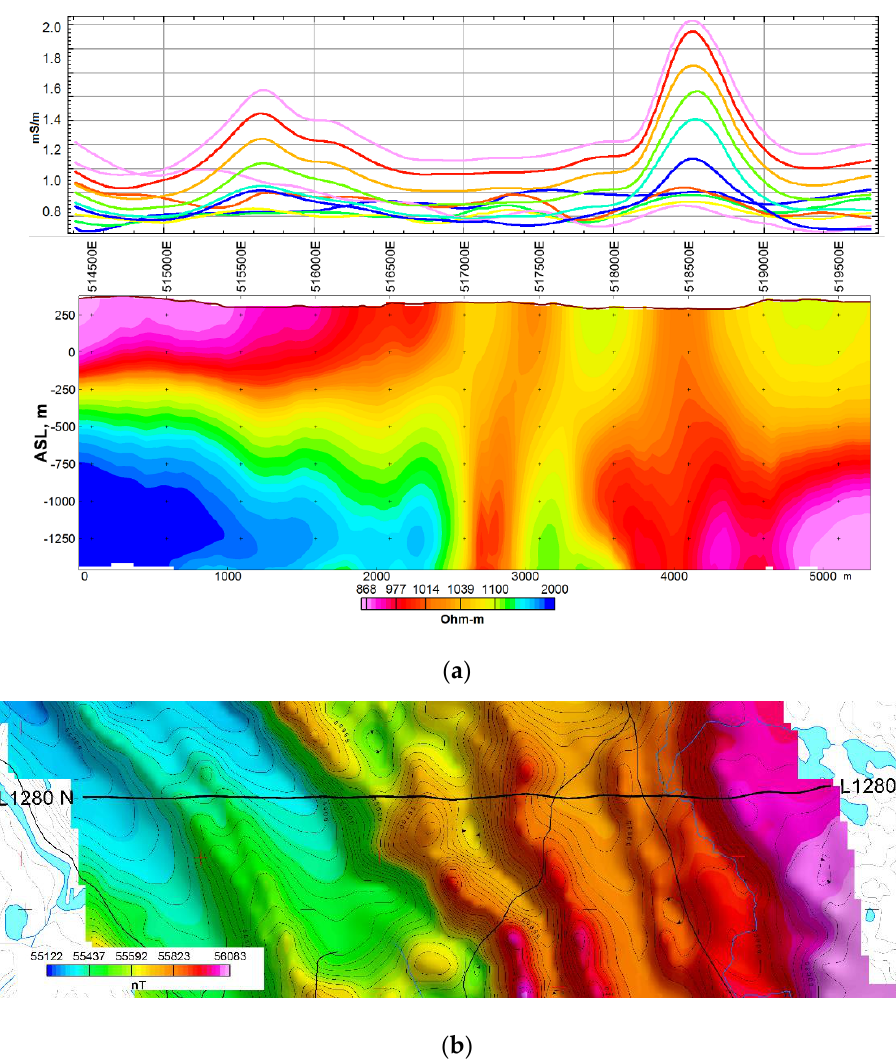
Figure 6. MobileMT apparent conductivity profiles ranging from 42 Hz to 13,619 Hz ( a ) top; resistivity-depth section (a) bottom; magnetic field map with the survey line position ( b ).